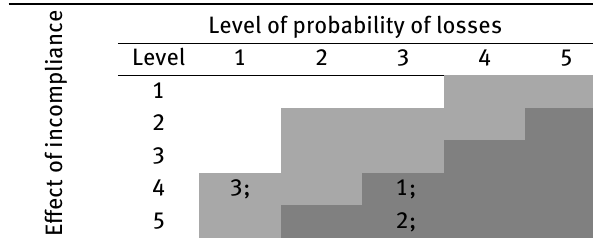
Table 3: Matrix of valuing technical risk for a stage of